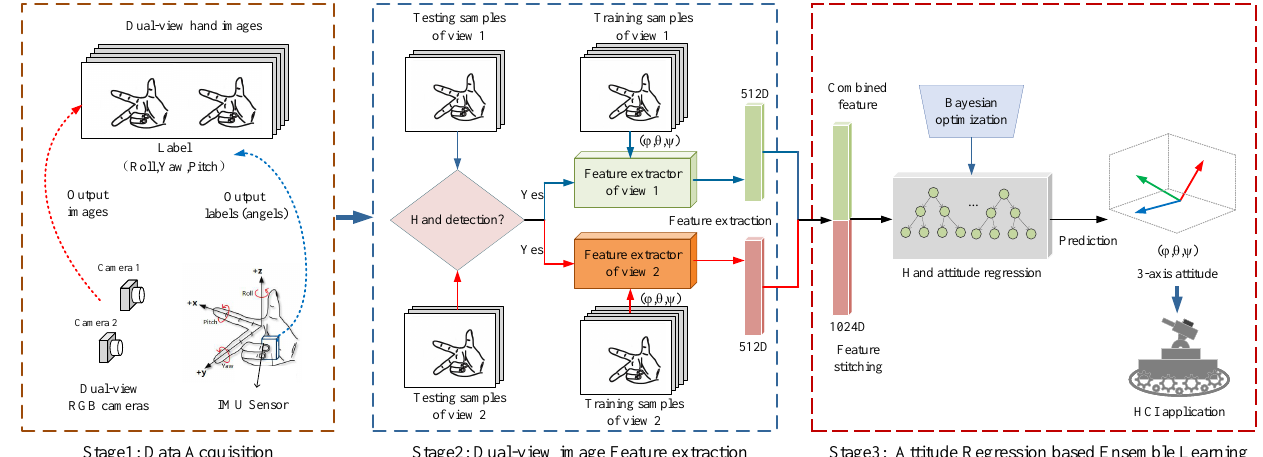
Figure 1. Overview of 3D hand attitude estimation method based on ConvLGBM